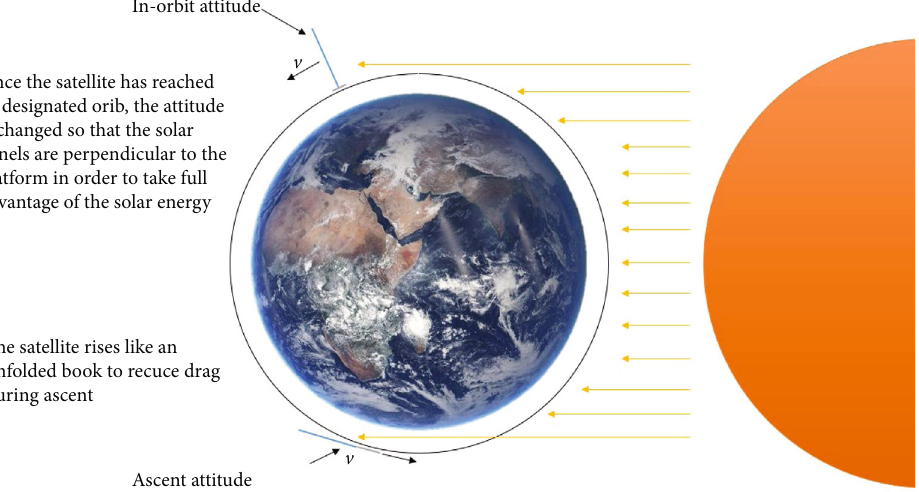
Figure 10: Satellite in-orbit attitude diagram.